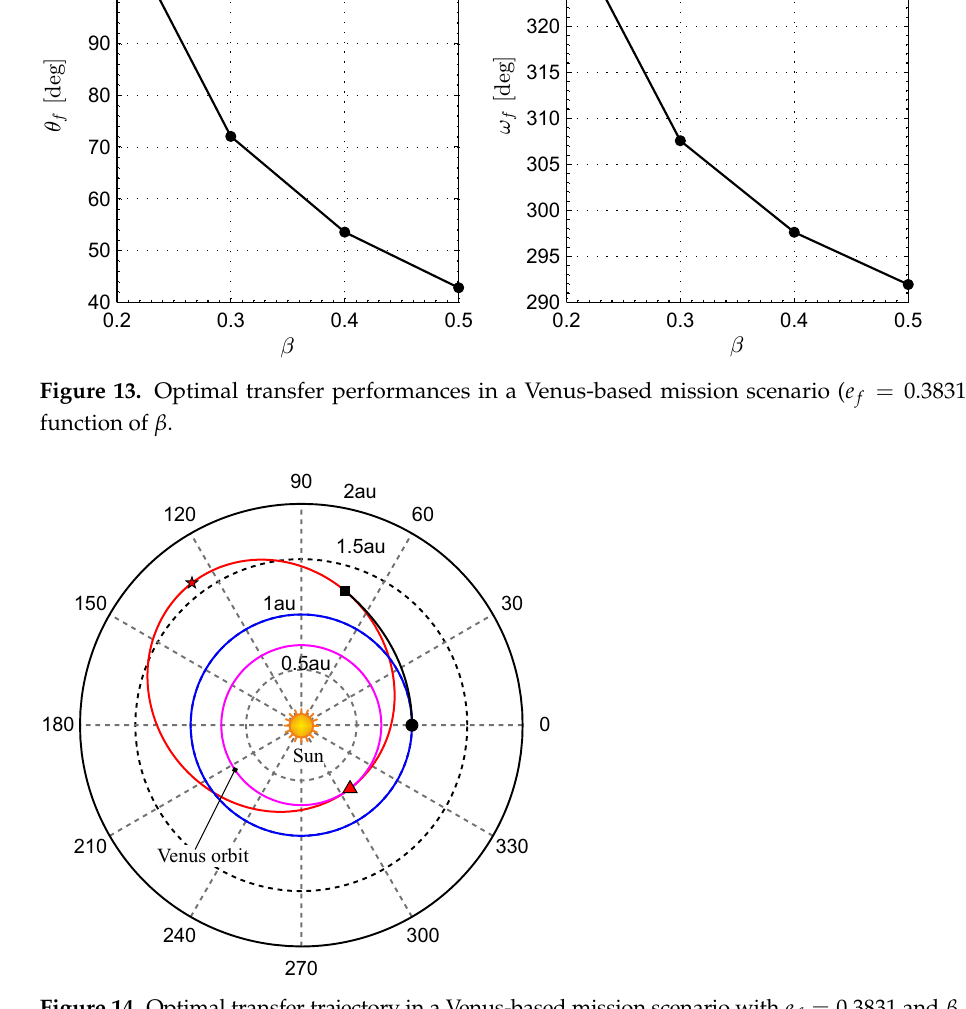
Figure 14. Optimal transfer trajectory in a Venus-based mission scenario with e f = 0.3831 and β =